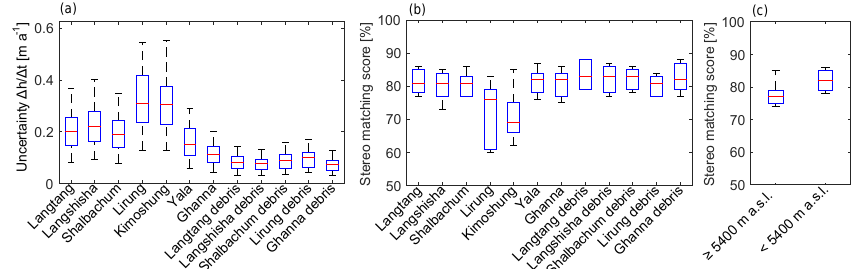
Figure 2. (a) Uncertainty estimates of average elevation change rates ( (cid:49)h/(cid:49)t ) per individual glacier and per debris-covered tongue. (b) En- semble of stereo matching scores per individual glacier and debris-covered tongue and (c) per glacier area above and below the estimated ELA. The central marks correspond to the median of all (cid:49)h/(cid:49)t maps or DEMs in the ensemble. The edges of each box are the 25th and 75th percentiles. The whiskers extend to the most extreme data points.